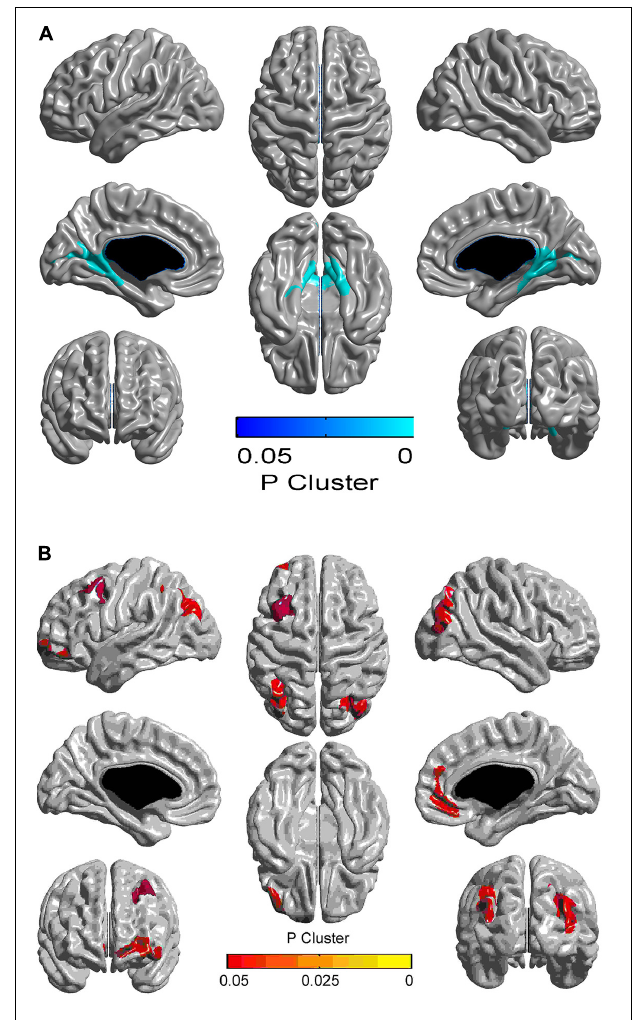
FIGURE 1 | Alterations in cortical thickness in young male patients with childhood-onset adult growth hormone deficiency. Clusters with FWE-corrected p < 0.05 are shown, and the color corresponds to the p -value. Areas in blue represent decreased cortical thickness in AGHD compared to controls, and yellow area represent increased thickness. (A) Clusters of significantly reduced cortical thickness in the AGHD group compared to controls. (B) Clusters of significantly increased cortical thickness in the AGHD group compared to